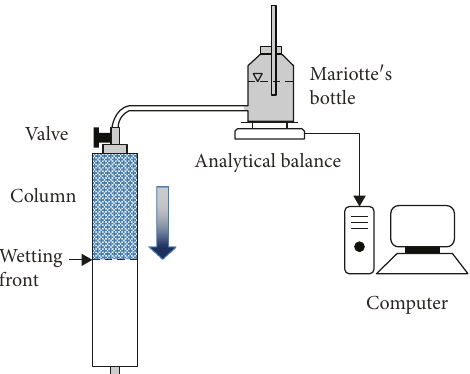
Figure 1: Schematic of the experimental setup for the downward in fi ltration experiments.